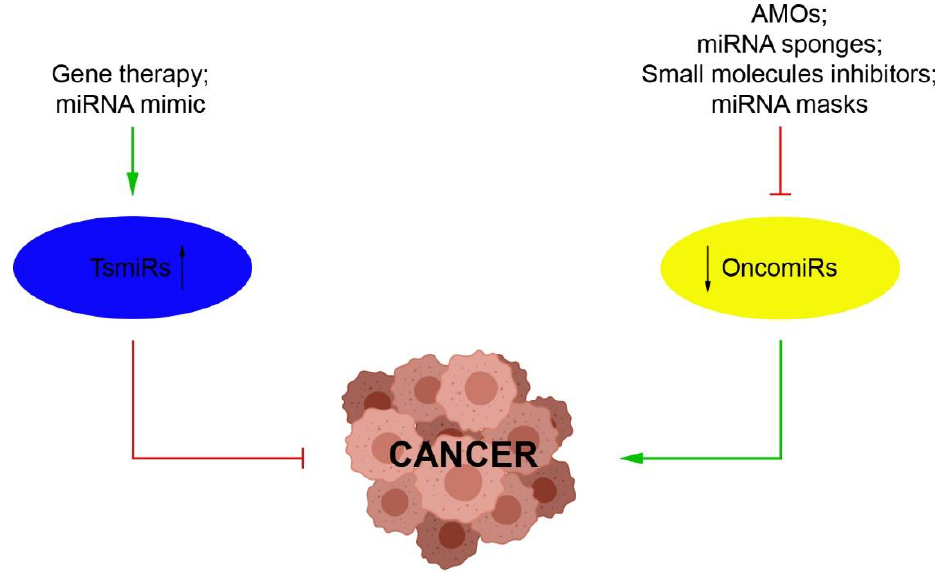
Figure 2. miRNA-based therapeutic intervention in cancer. Through inhibition of oncogenic miRNAs (Oncomirs), miRNA expression is modulated using small molecule inhibitors, anti-miR oligonucleotides (AMOs), miRNA masks/target protectors or miRNA sponges, or by reconstituting tumor suppressor miRNAs (TsmiRs), through delivery of miRNA mimics or gene therapy. BioRender has been used to create parts of this figure. (https://biorender.com, accessed on 26 March 2021).